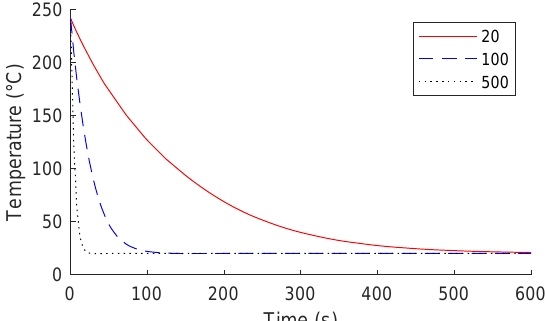
Figure 1. Thermal analysis of experiments performed in [3]; Legend values indicate convection coefficient (W/(m 2 K)).